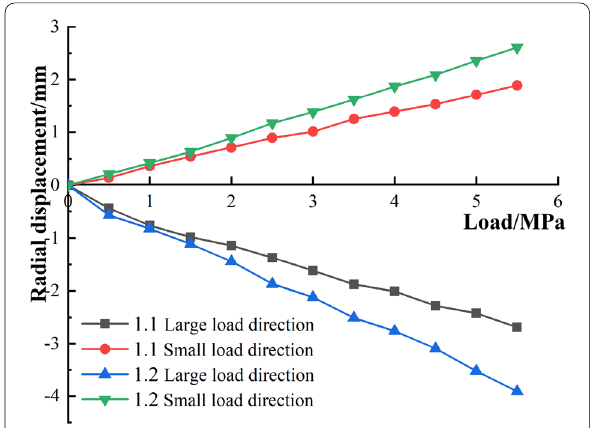
Fig. 17 Load–radial displacement relationship curve of shaft wall. Fig. 18 Shaft wall failure